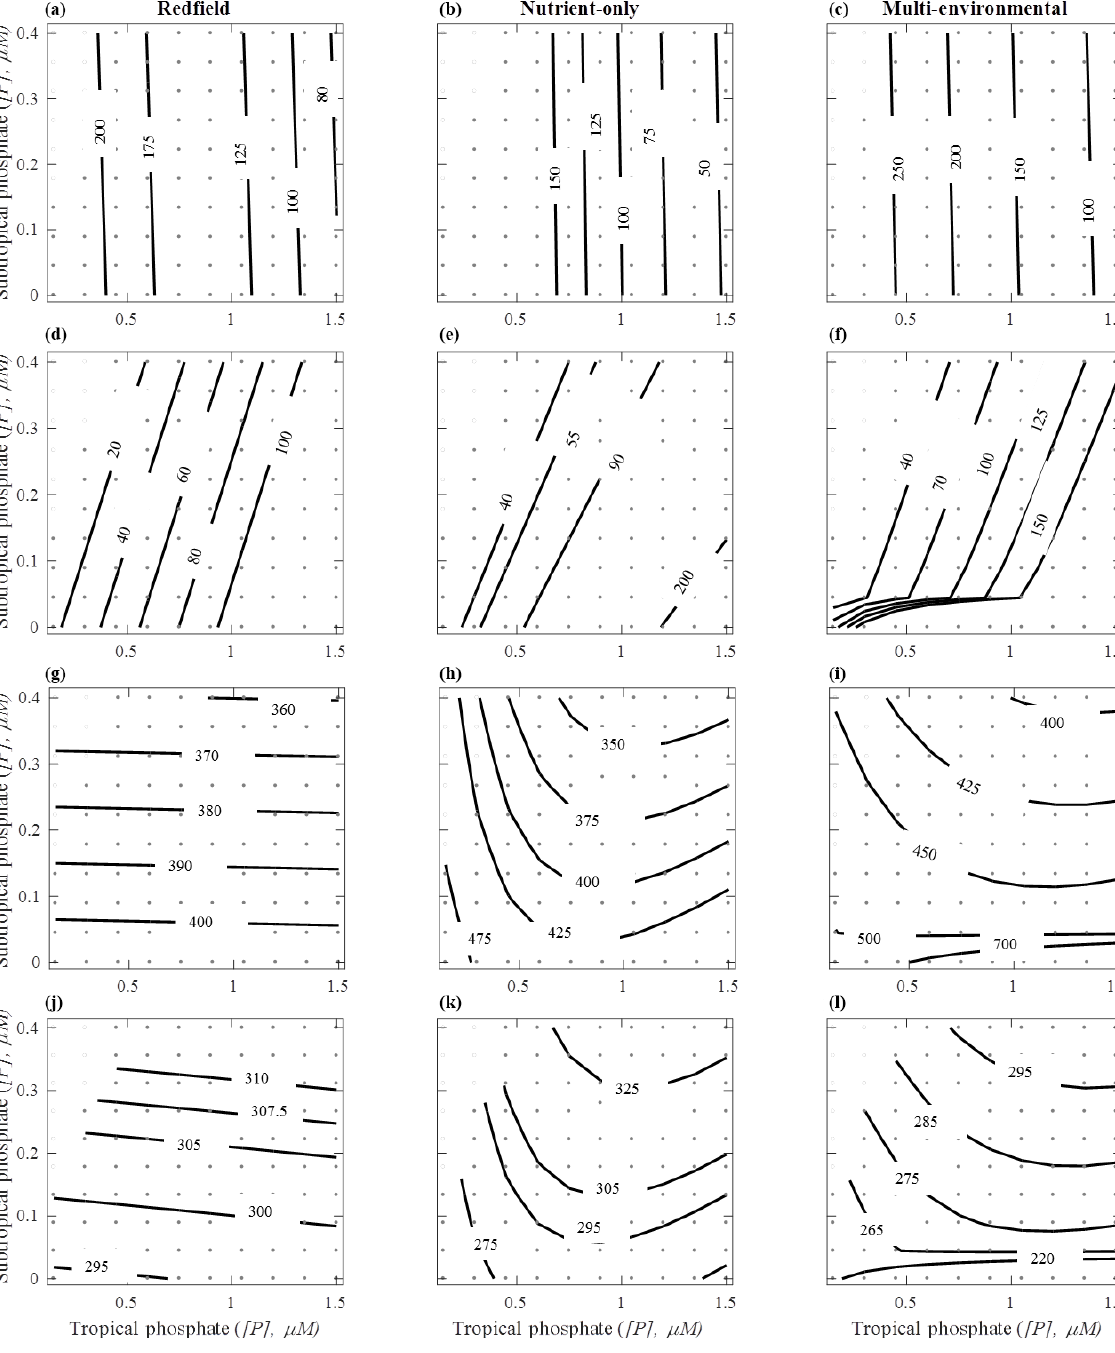
Figure 9. Carbon export ( T molCyr − 1 ) and p CO 2 , atm (ppm) in changing surface phosphate concentrations. Columns correspond to type of stoichiometry: Redfield (a, d, g, j) , nutrient-only (b, e, h, k) , and multi-environmental model (c, f, i, l) . Rows correspond to either tropical carbon export (a–c) , subtropical carbon export (d–f) , total carbon export (g–i) , or atmospheric p CO 2 (j–l) . The grey points represent where p CO 2 , atm was calculated, between spaces are